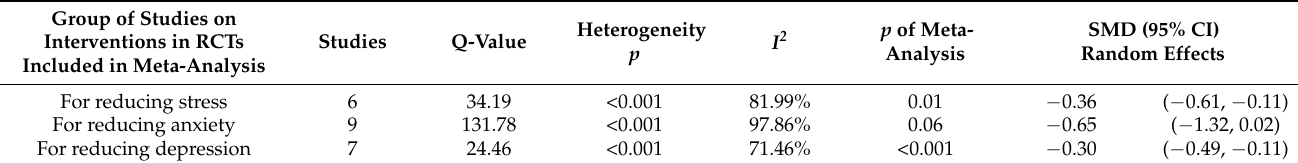
Table 3. Results of the